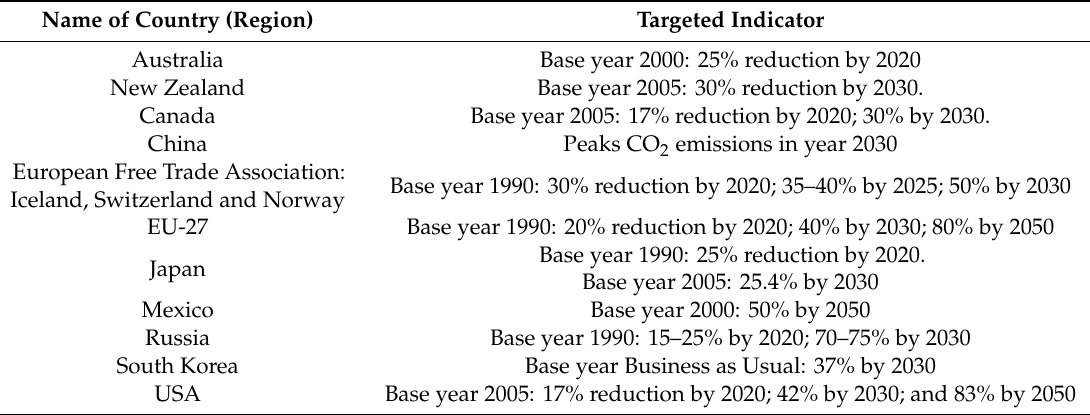
Table 3. Targeted emission reduction policy scenario for di ff erent regions and countries simulated using the integrated